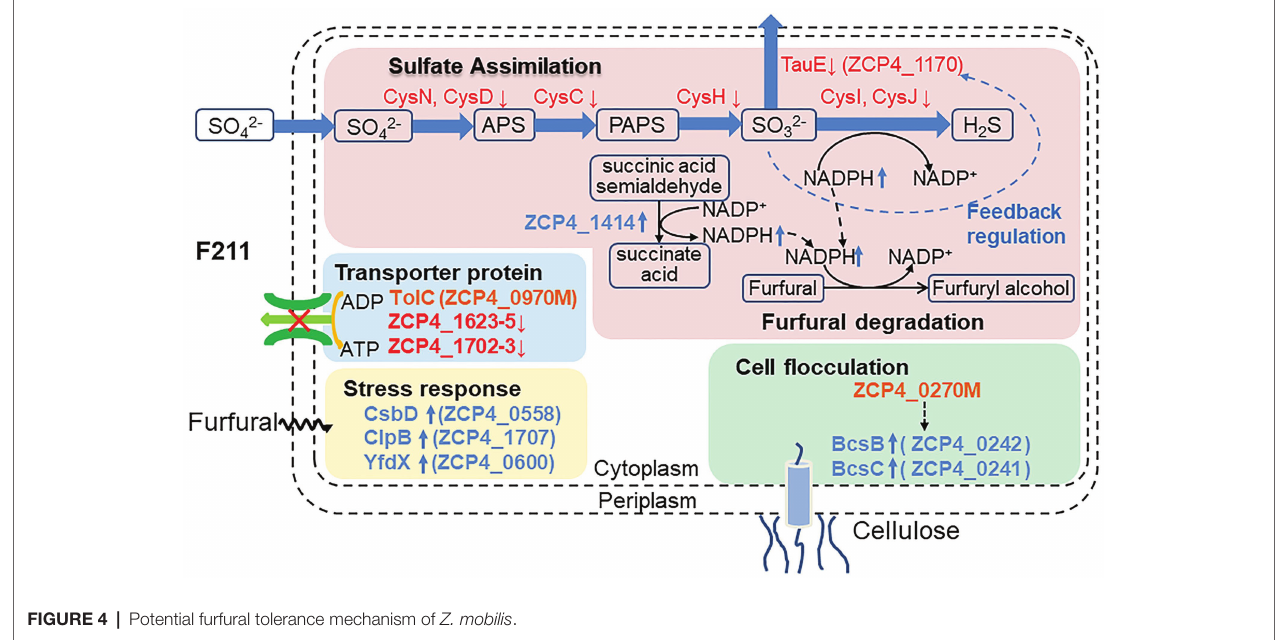
FIGURE 4 | Potential furfural tolerance mechanism of Z. mobilis